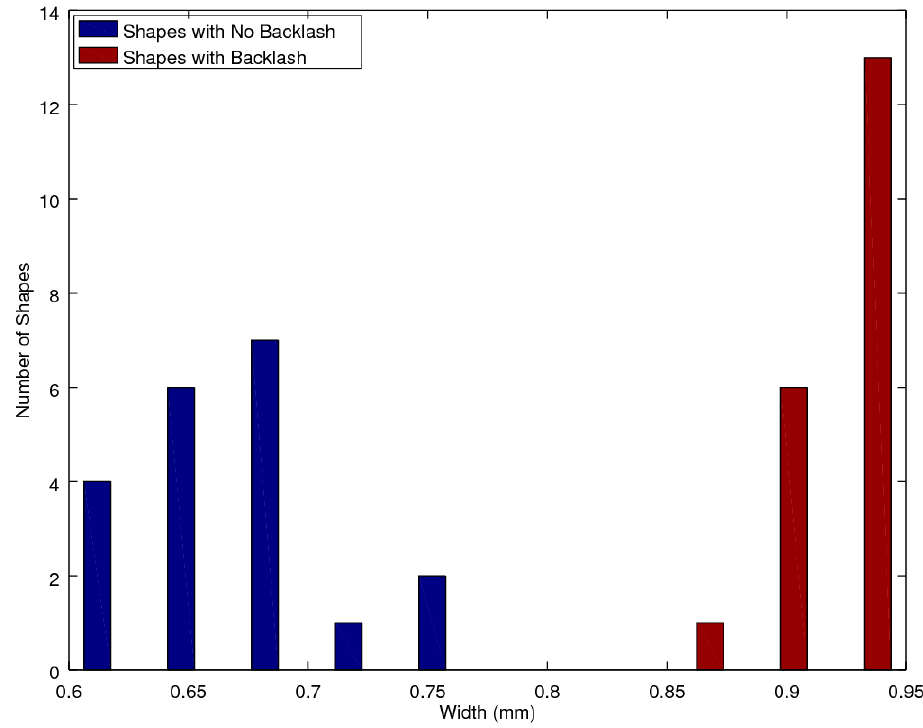
Figure 13. A histogram of feature widths measured on the Y-axis.